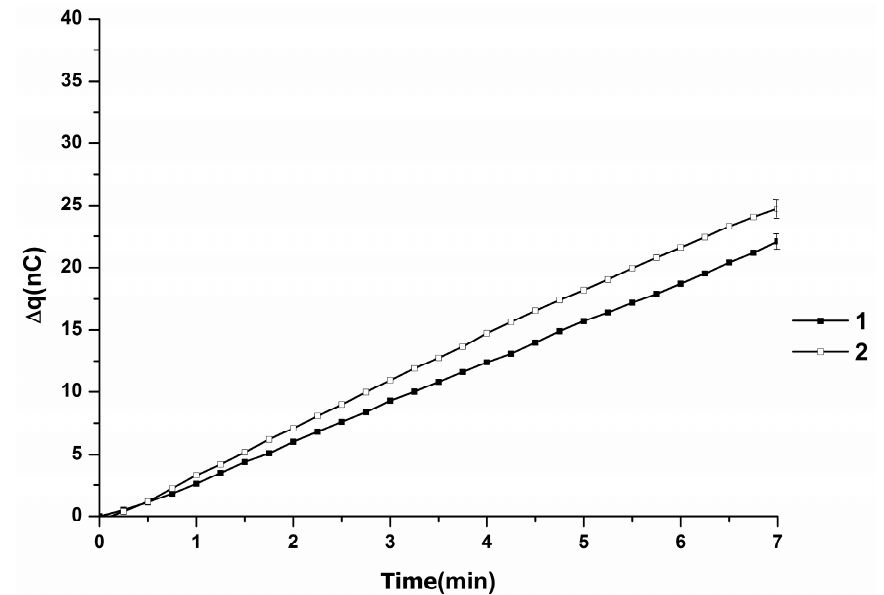
Figure 6. The effect of the presence of HOPG on the charge generation in water. Averaged Δ q(t) dependencies obtained upon pumping of water through the injector. Experimental conditions: without HOPG ( 1 ); with HOPG ( 2 ). The distance between the injector nozzle and the HOPG chip is l = 10 mm. T = 35 °C. The data of one and the same experimental series obtained using one and the same tube ‐ pipe ‐ tip set (see the Materials and Methods section) are presented.